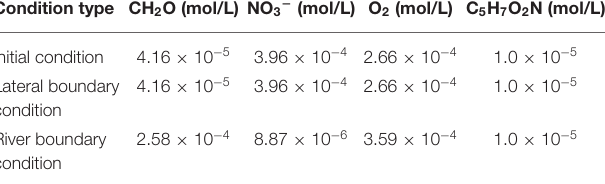
TABLE 2 | Reactive transport conditions.